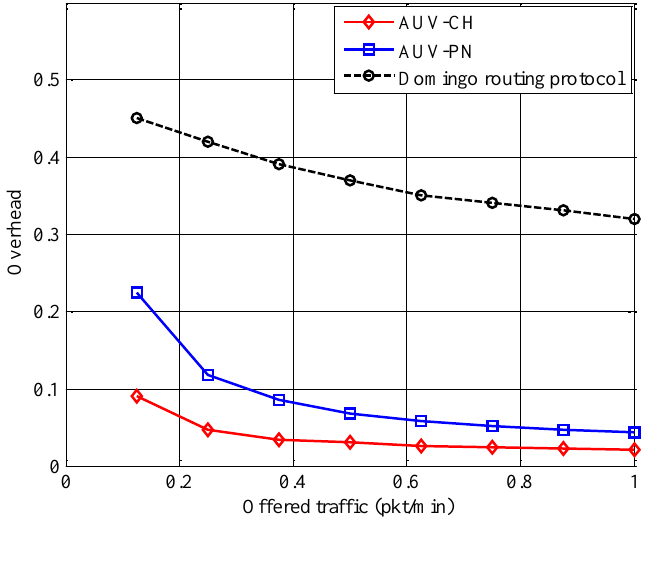
Figure 13. Protocol